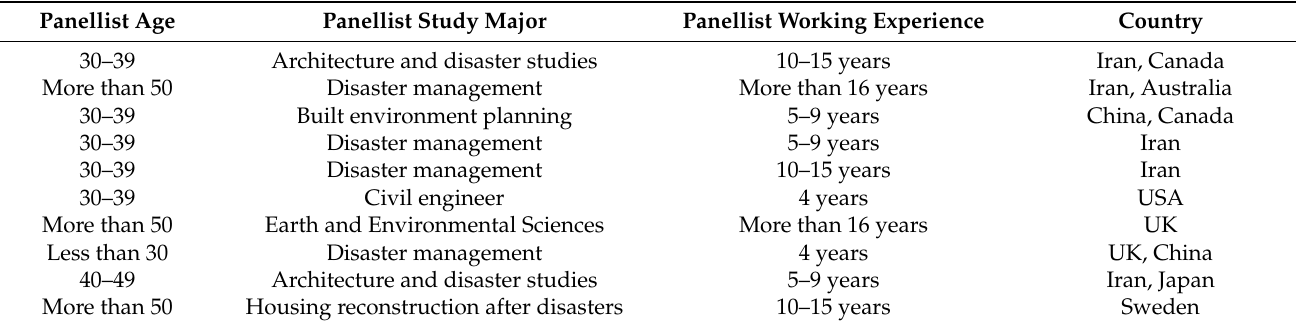
Table 1. Demographic information of the panel